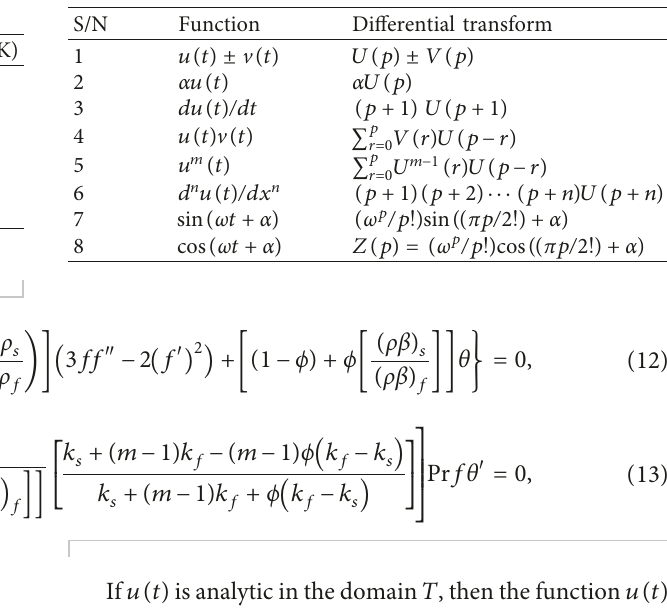
Table 3: Physical and thermal properties of the nanoparticles Table 4: Operational properties of differential transformation